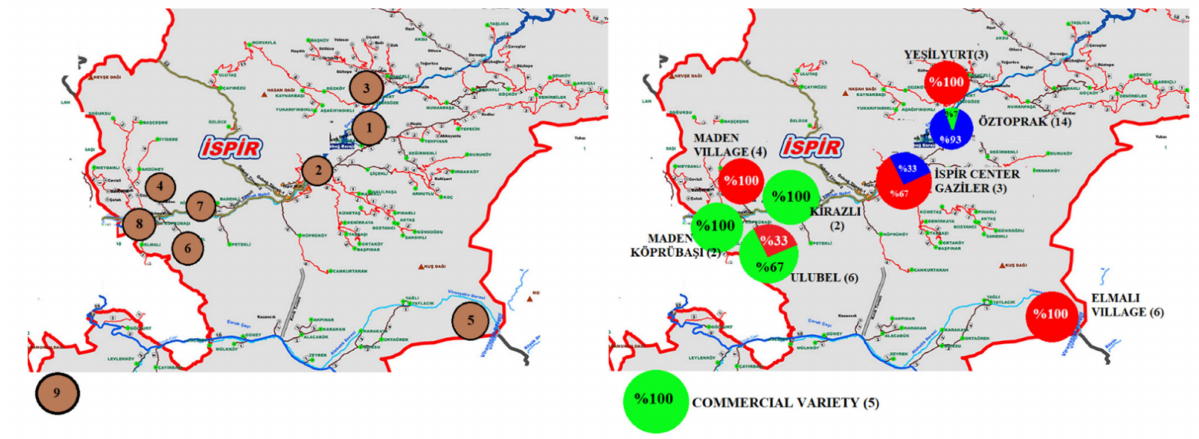
Figure 5. Geographical distribution of 45 bean genotypes identified by the STRUCTURE program using 27 SSR markers by region (1: Öztoprak, 2: Ispir Center Gaziler Neighborhood, 3: Ye¸silyurt Village, 4: Maden Village, 5: Elmalı District A˘gıldere Village, 6: Ulubel Village, 7: Kirazlı Village,